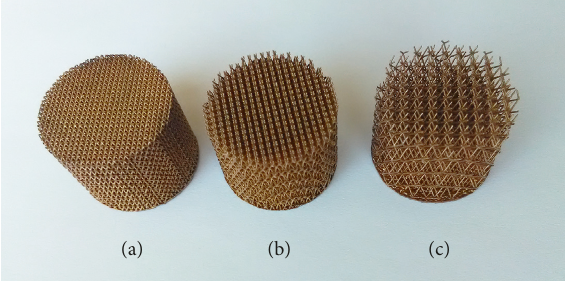
Figure 9: DigitalopticalphotosofheatedandnitridedTi6Al4Vlattices at 900 ° C with volume fraction and unit cell size of 26% and 0.75mm (a); 16% and 1.00mm(b); and 6% and 2.00mm (c), respectively (diameter of lattice structures is 20mm, and length is